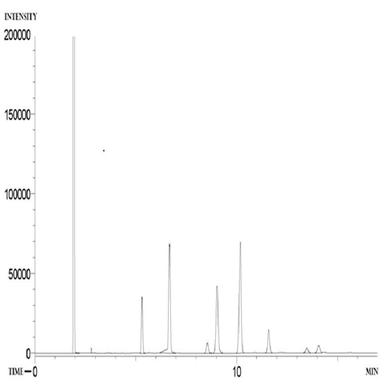
GC Chromatogram of Peelu Crop Biodiesel Showing Six Major FAMEs Lab. Synthesized Sample.